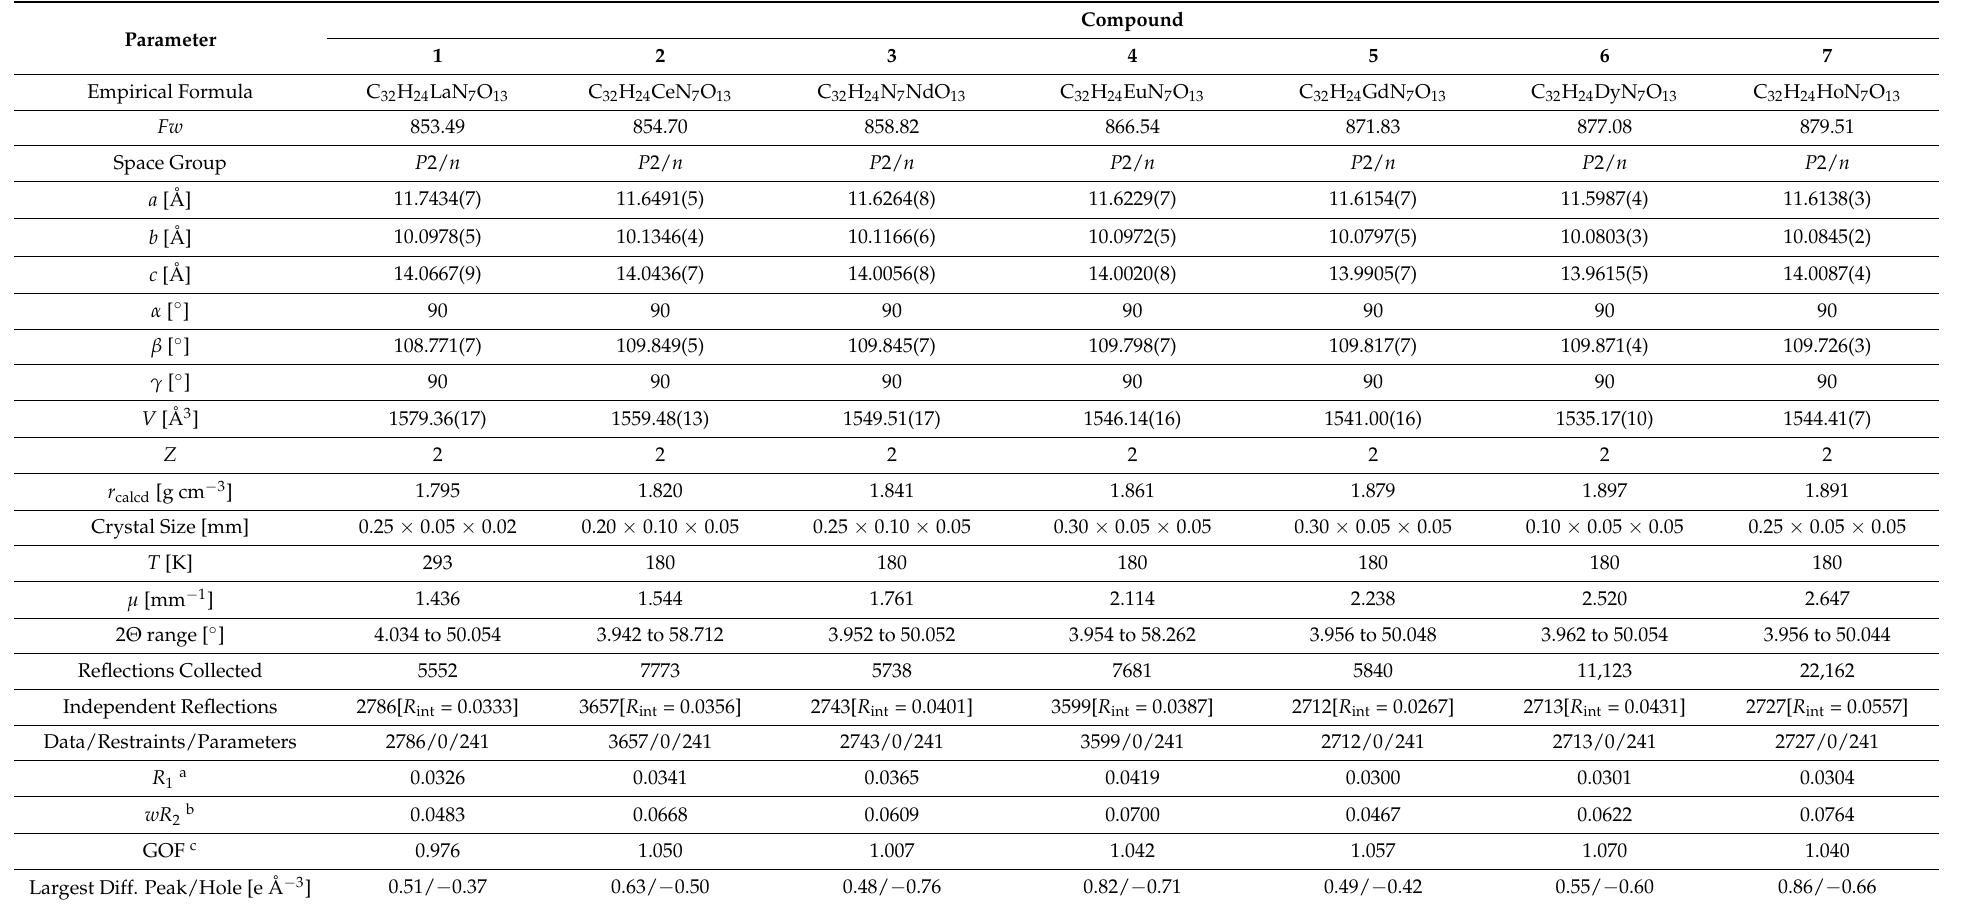
Table 1. Crystal data and details of data